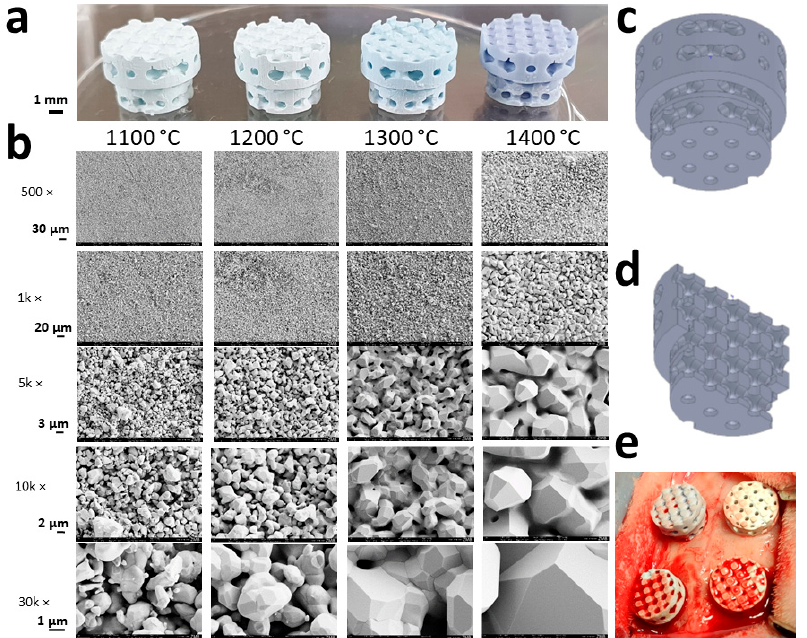
Figure 1. Macrographies and SEM images of the experimental scaffolds: ( a ) Scaffolds, which under- went different sintering temperatures, are shown to maintain their macro- and microarchitecture; ( b ) sintering temperatures applying to panel a and b are provided. SEM micrographs from the respective scaffolds are displayed with scales to the left; ( c ) the macroarchitecture of the full scaffold; ( d ) the macroarchitecture of the halved scaffold; ( e ) a picture taken after placement of all four different scaffolds in the calvarial bone defects of a rabbit is